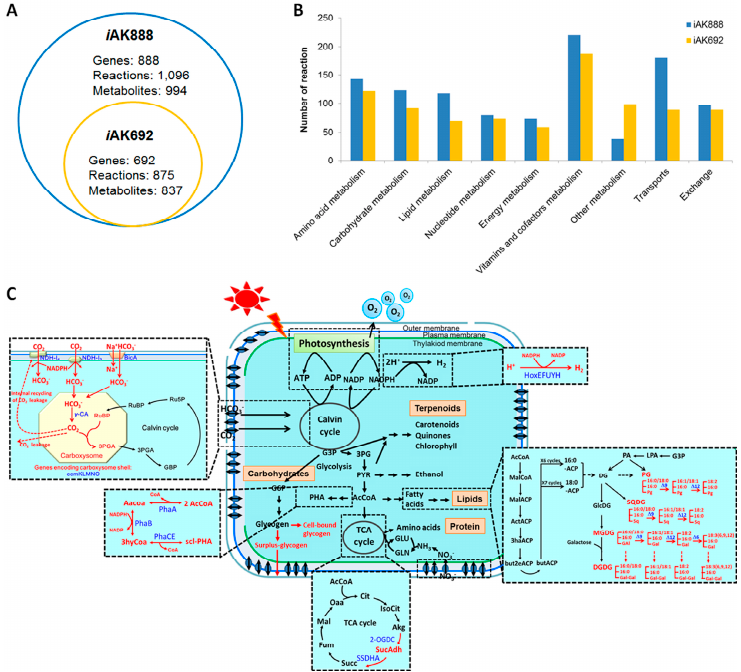
Figure 2. Comparison between i AK888 and i AK692. Overview features of i AK888 compared to i AK692 ( A ). Number of reactions in each metabolism of i AK888 compared to i AK692 ( B ). Schematic representation of i AK888 and the example of the filled pathways compared to i AK692 ( C ). Zoomed out sections are pathways that were completed in i AK888. Red texts and arrows indicate missing pathways in i